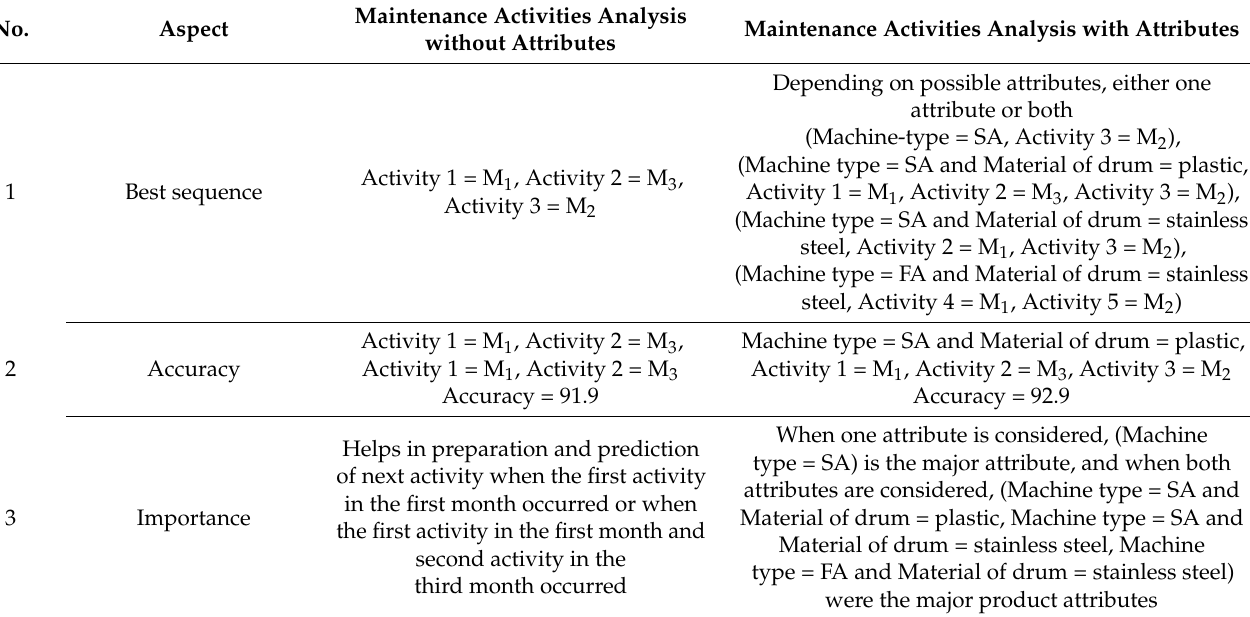
Table 18. Comparison of maintenance activities analysis with and without